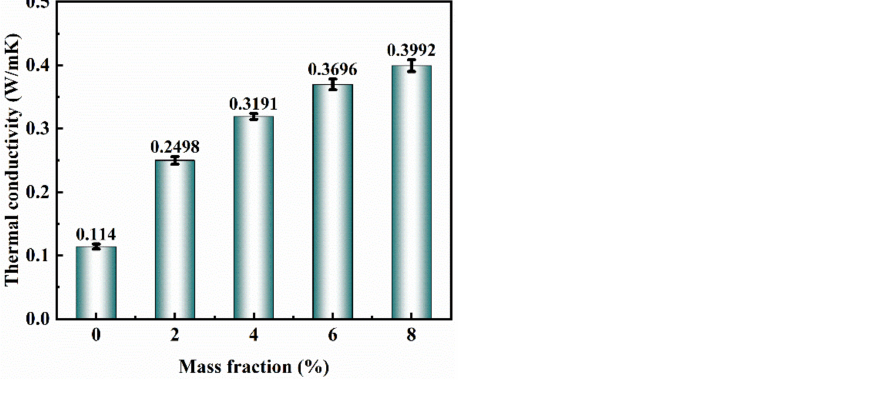
Figure 10. Thermal conductivity of WM films with modified MG.